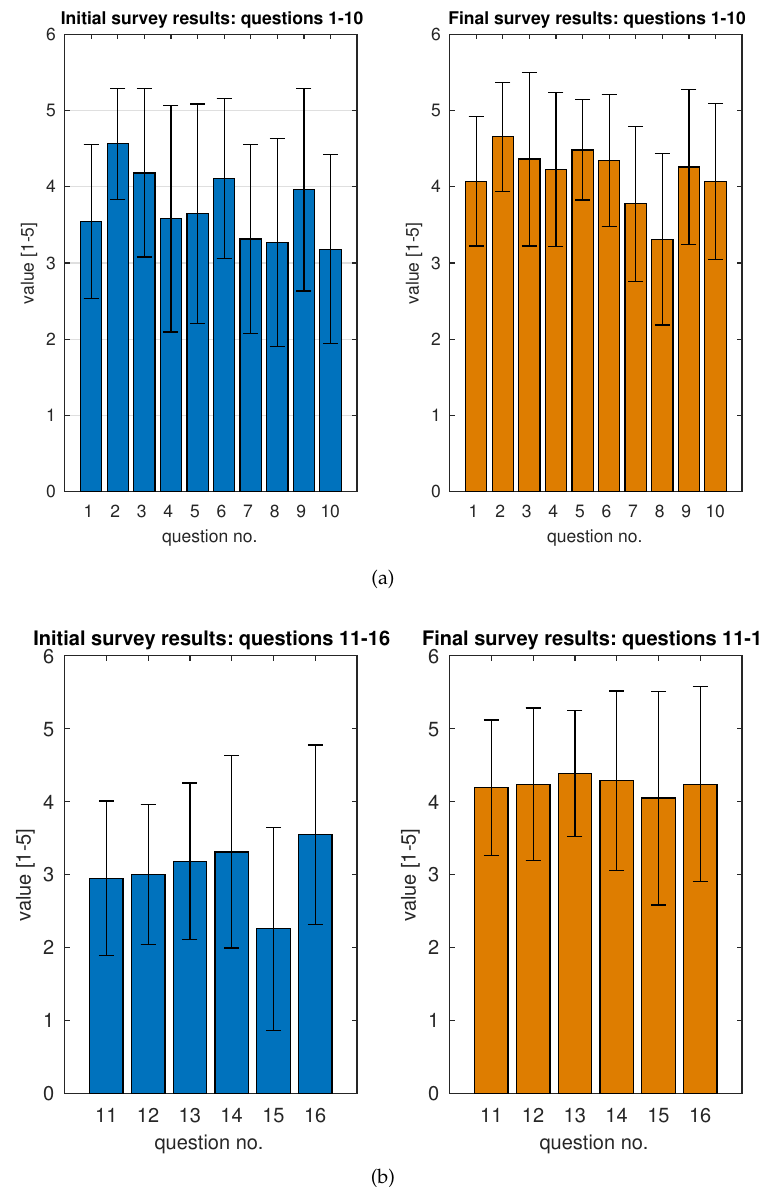
Figure 3. Left axes (cid:4) : survey results acquired during the 1 st week of the course. Right axes (cid:4) : survey results acquired during the 15th week of the course. Questions 1–10 ( a ). Questions 11–16 ( b ). Results are expressed with mean values and standard